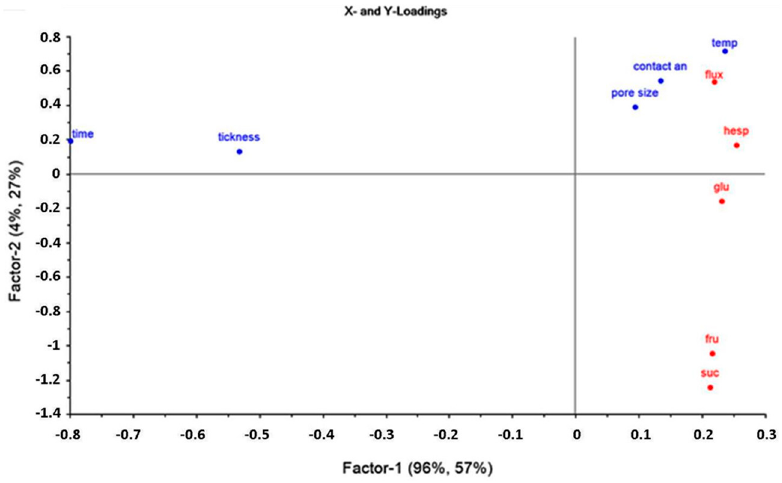
Figure 6. PLS loading plot for the two principal factors.